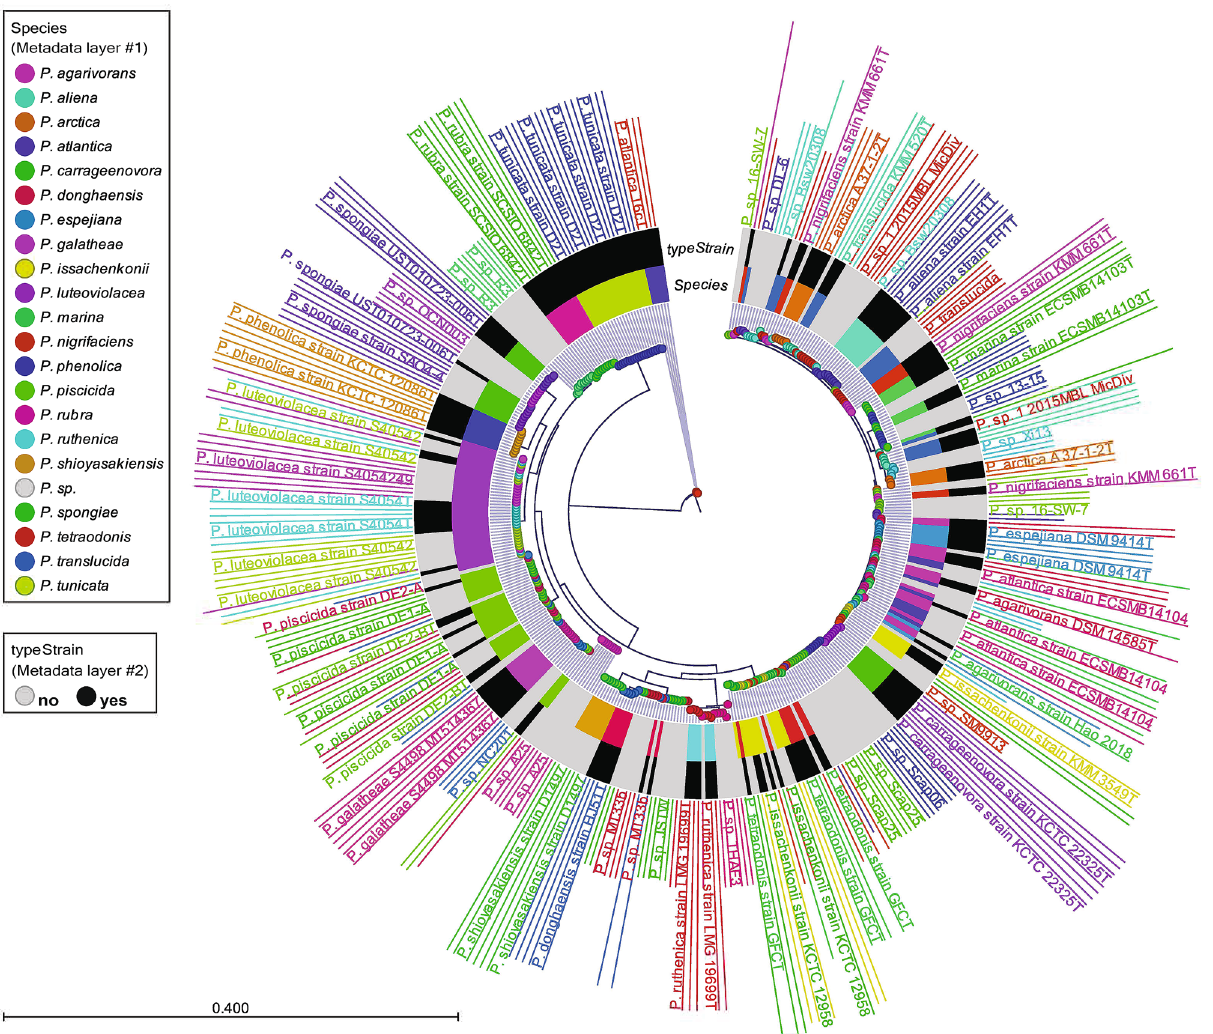
Figure 2. Phylogenetic tree of all alleles of 16S rRNA genes in Pseudoalteromonas genomes considered ‘complete’ in NCBI. Nodes and label colors correspond to individual genomes. Inner color ring and outer ring denotes species and type strain status (black = type strain, grey = no type strain), respectively. Labels have been compressed to avoid overlapping. P. atlantica T6c T has been used as